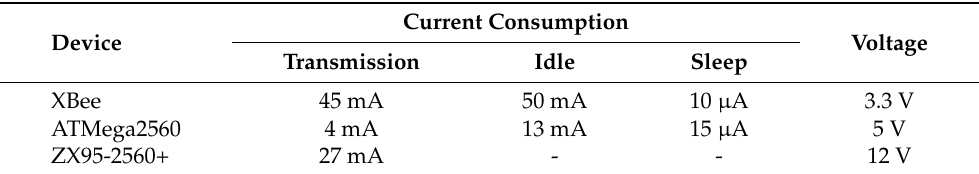
Table 1. Current consumption for each state and operation voltage for each device used in the exper- imental testbed [29,32,33]. The consumption of the devices used for the synchronization and the tuning circuit are not considered for the comparison analysis.